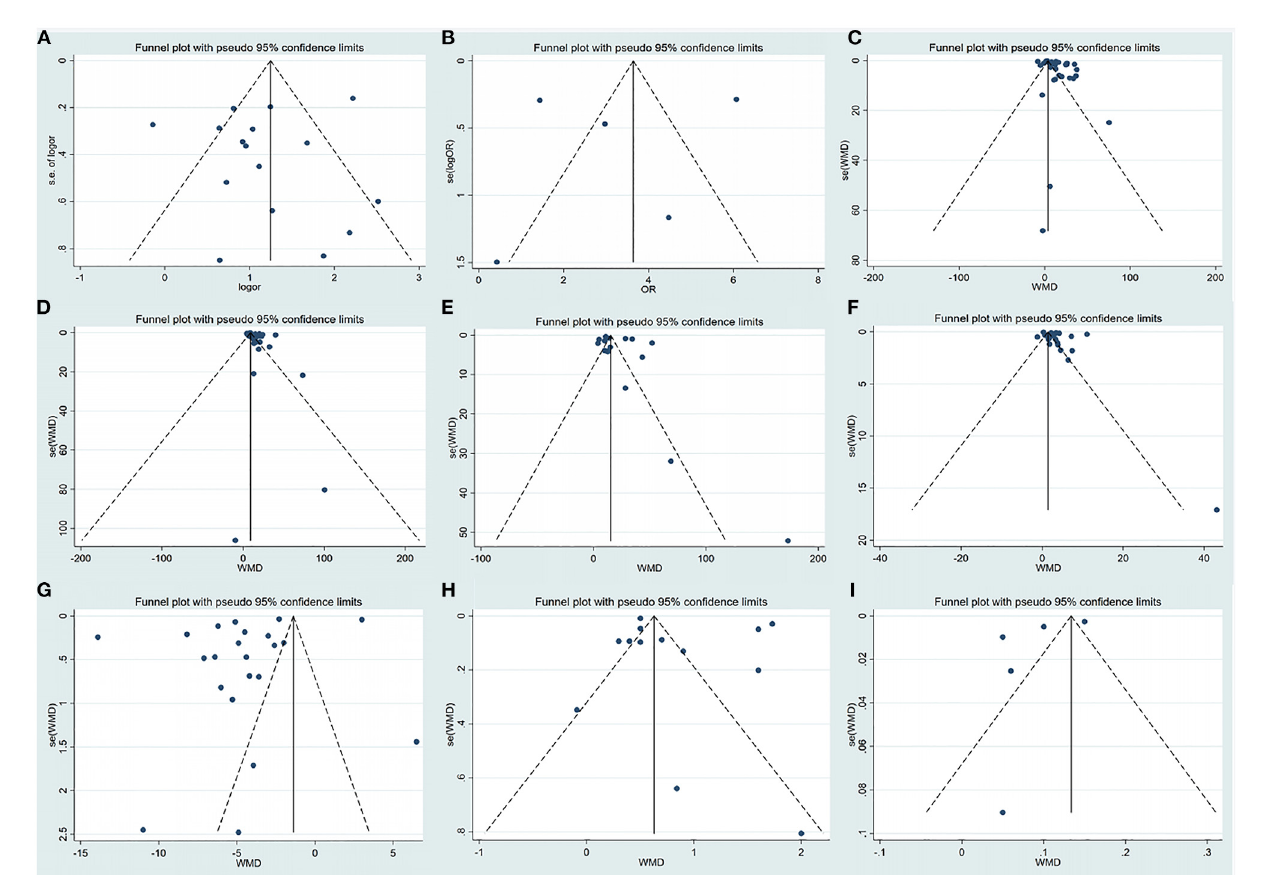
FIGURE5 Funnel plot of the included studies evaluating abnormal liver chemistries between severe and non-severe patients with COVID-19. (A) Prevalence of liver injury. (B) The mortality association with COVID-19 infection between liver injury and non-liver injury cases. (C) Serum ALT levels. (D) Serum AST levels. (E) Serum GGT levels. (F) Serum TBIL levels. (G) Serum ALB levels. (H) Serum PT levels. (I) INR levels. ALT, alanine aminotransferase; AST, aspartate aminotransferase; GGT, gamma-glutamyl transferase; TBIL, total bilirubin; ALB, albumin; PT, prothrombin time; INR, international normalized